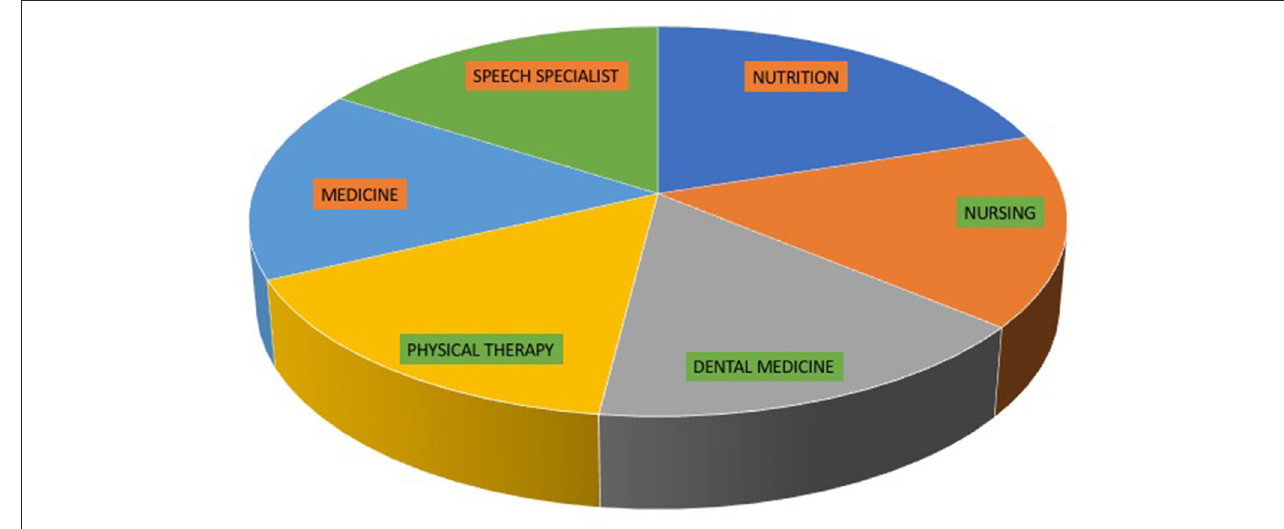
FIGURE 1 | The “team approach” that should be implemented for all overall health